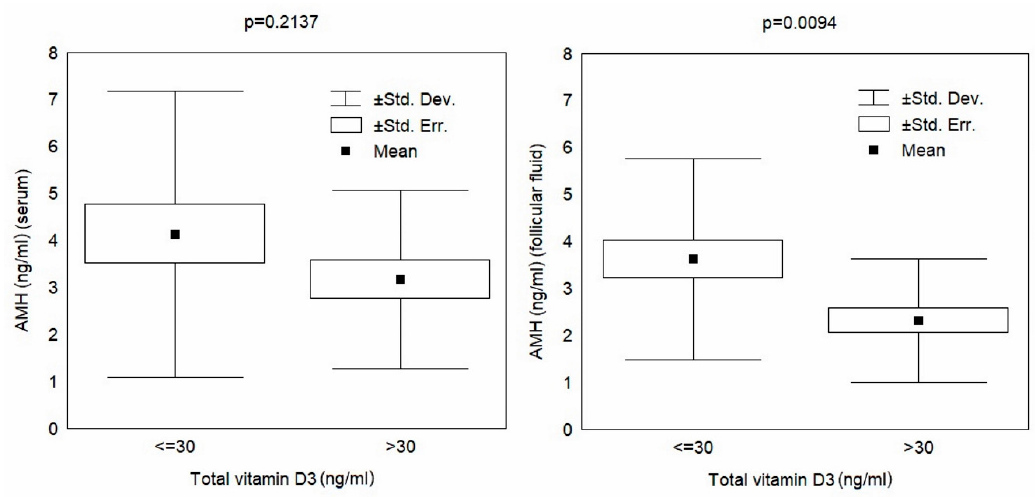
Figure 2. AMH (anti-Müllerian hormone) in serum and in follicular fluid relative to the vitamin D norm (30 ng/mL).